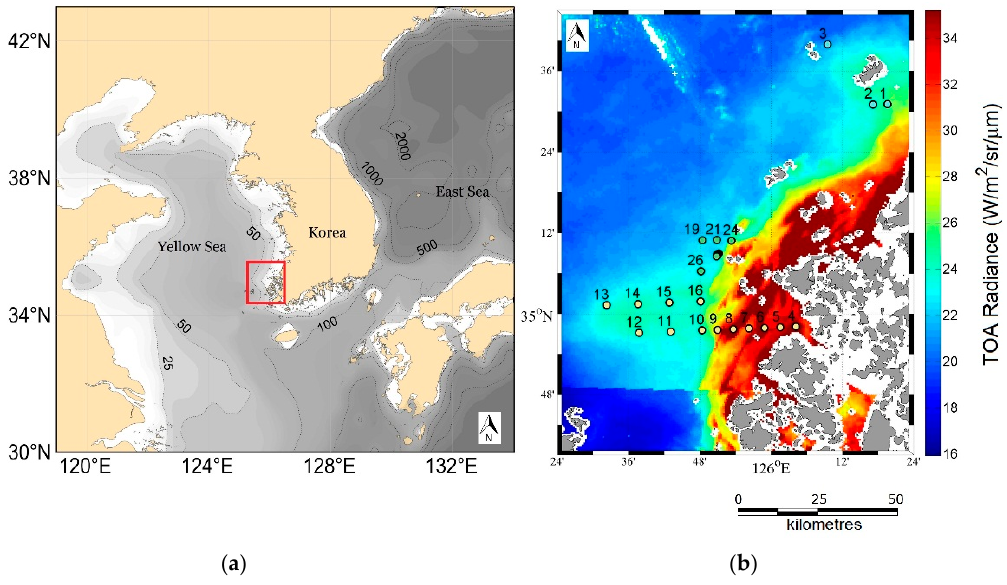
Figure 1. Locations of the study area ( a ) and the in situ measurement sites ( b ) in the SW coast of Korea are presented. For the station map ( b ), GOCI image of TOA radiance in the 680-nm band is used as background. Table 1. Times and locations of the 26 in situ radiometric measurements used for this study. Time is in Coordinated Universal Time (UTC).